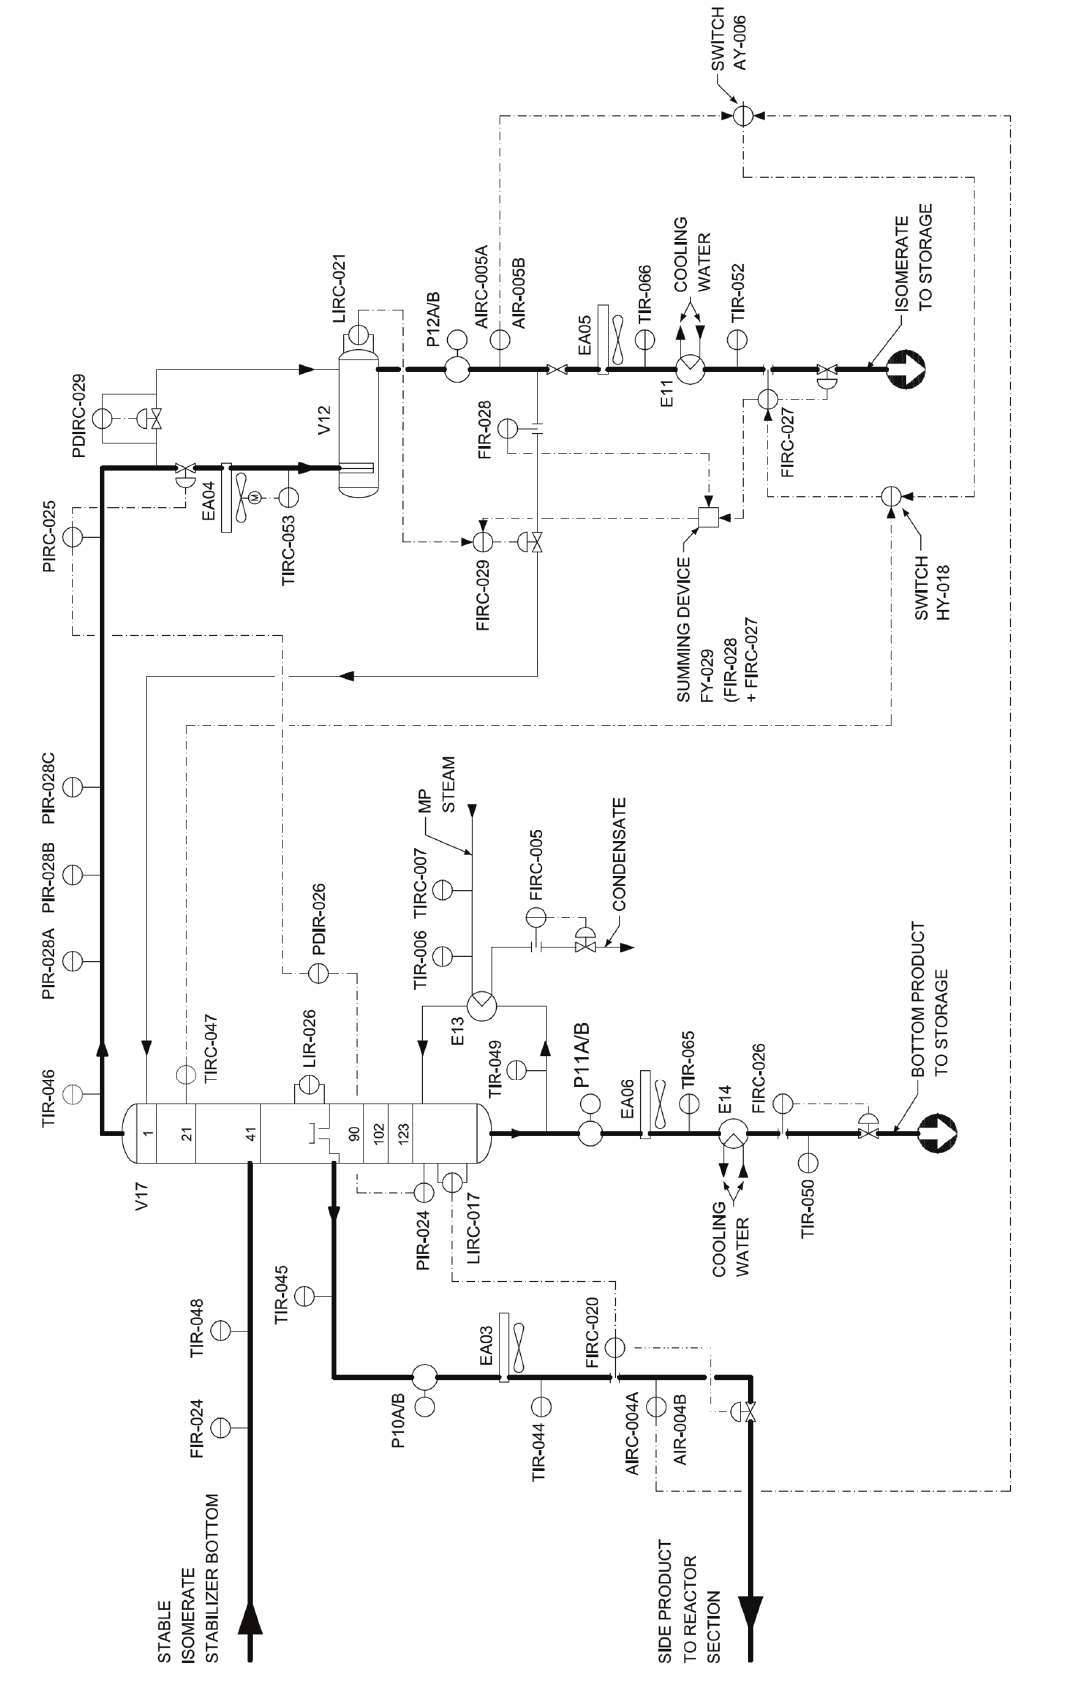
Fig. 5 – Process flow diagram of the observed plant deisohexanizer